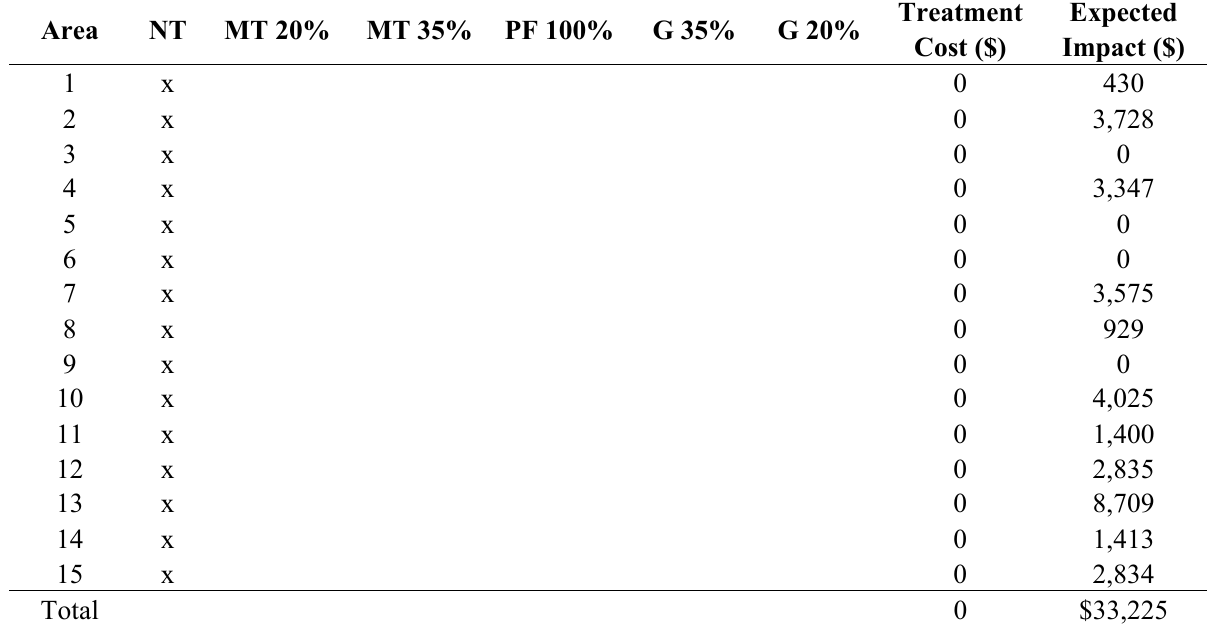
Table 5. Fuel treatment plan based on an ecosystem services factor of 1 and fireline intensity threshold of 1000